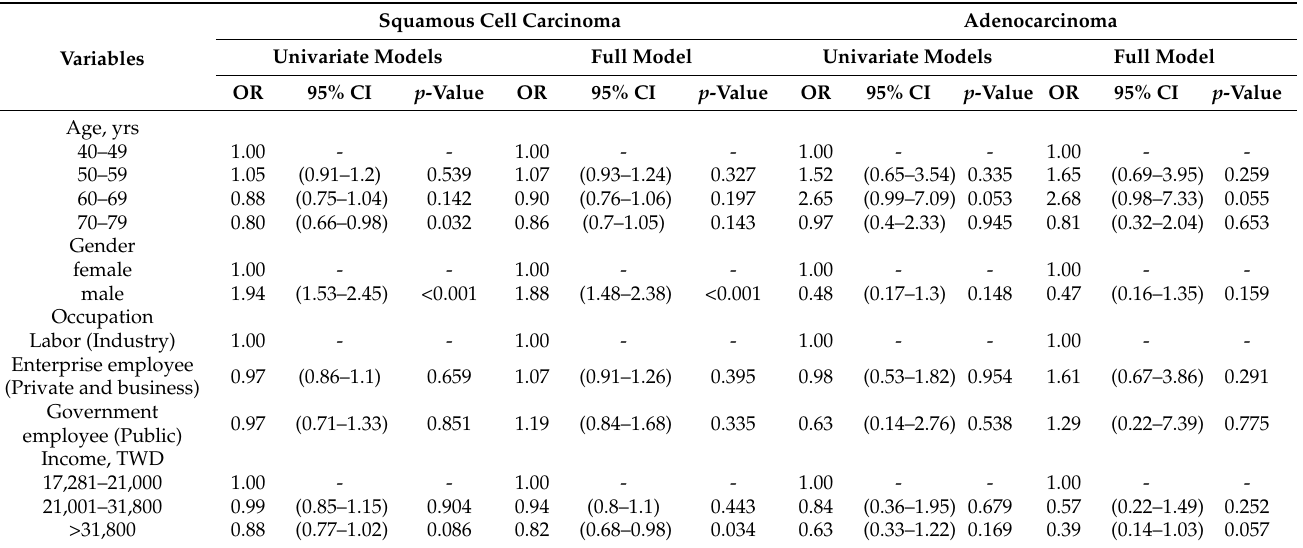
Table 5. Univariate and multivariable logistic regression models of late-stage (Stage III + IV) di- agnosis in patients with esophagus cancer.